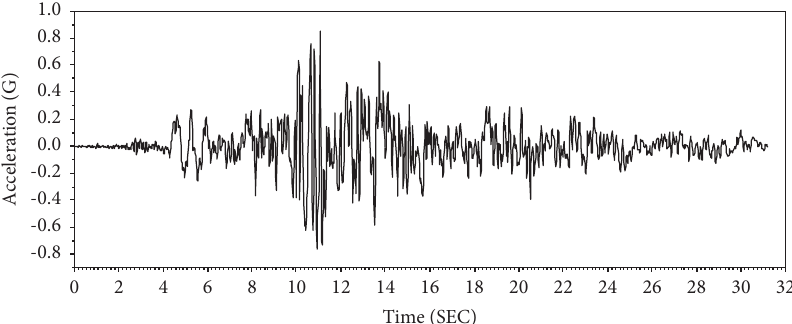
Figure 12: Tabas, Iran 09/16/78 seismic wave.